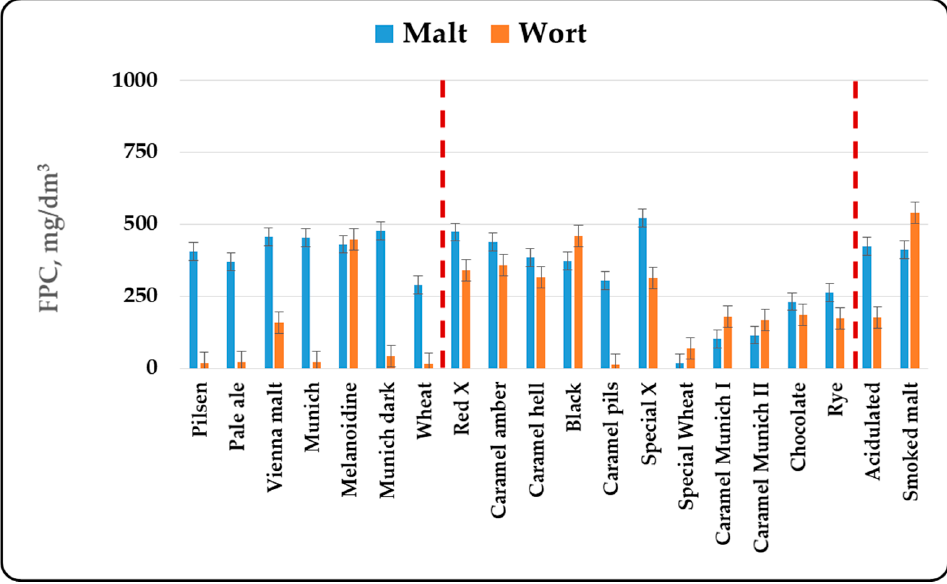
Figure 4. Flavonoid phenolic compounds in different malt types, determined by the direct spectral method.